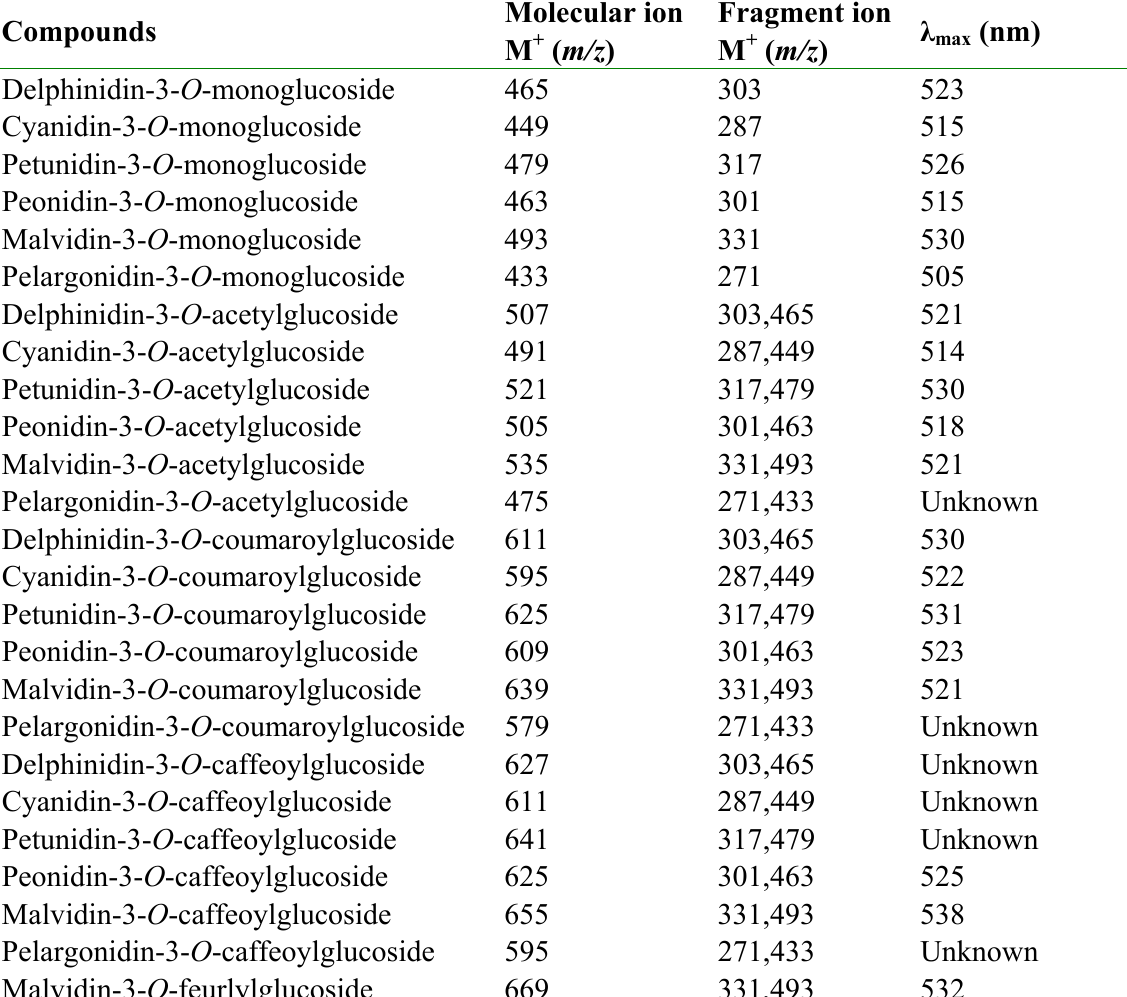
Table 1. The mass spectral and UV-vis data of the major free anthocyanins in various red wines that made from V. vinifera grapes